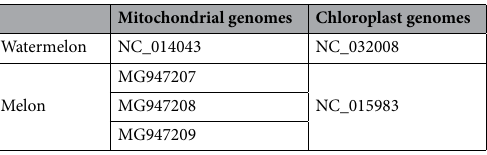
Table 1. GeneBank numbers for watermelon and melon organelle